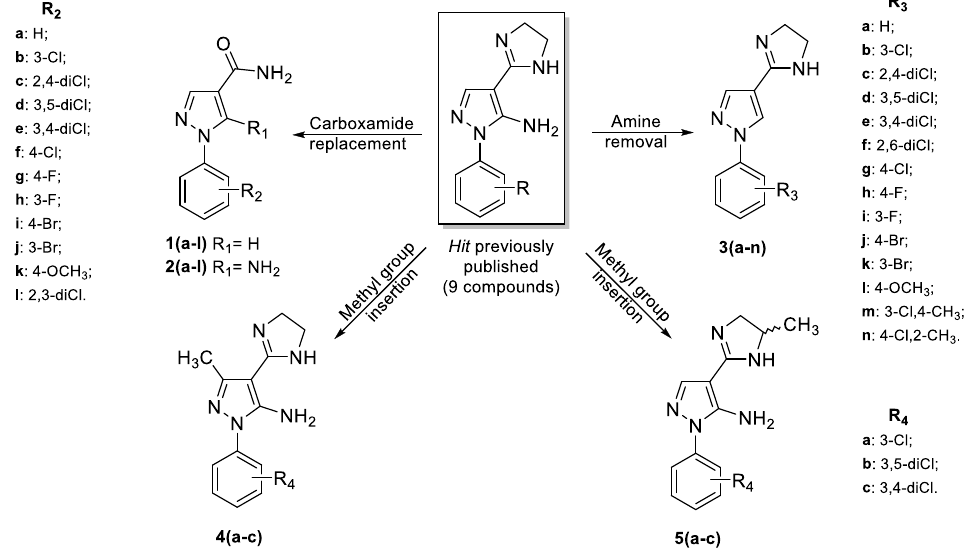
Figure 1. Rational planning of 1 ( a – l ), 2 ( a – l ), 3 ( a – n ), 4 ( a – c ), and 5 ( a – c ) from the hit previously pub- lished.